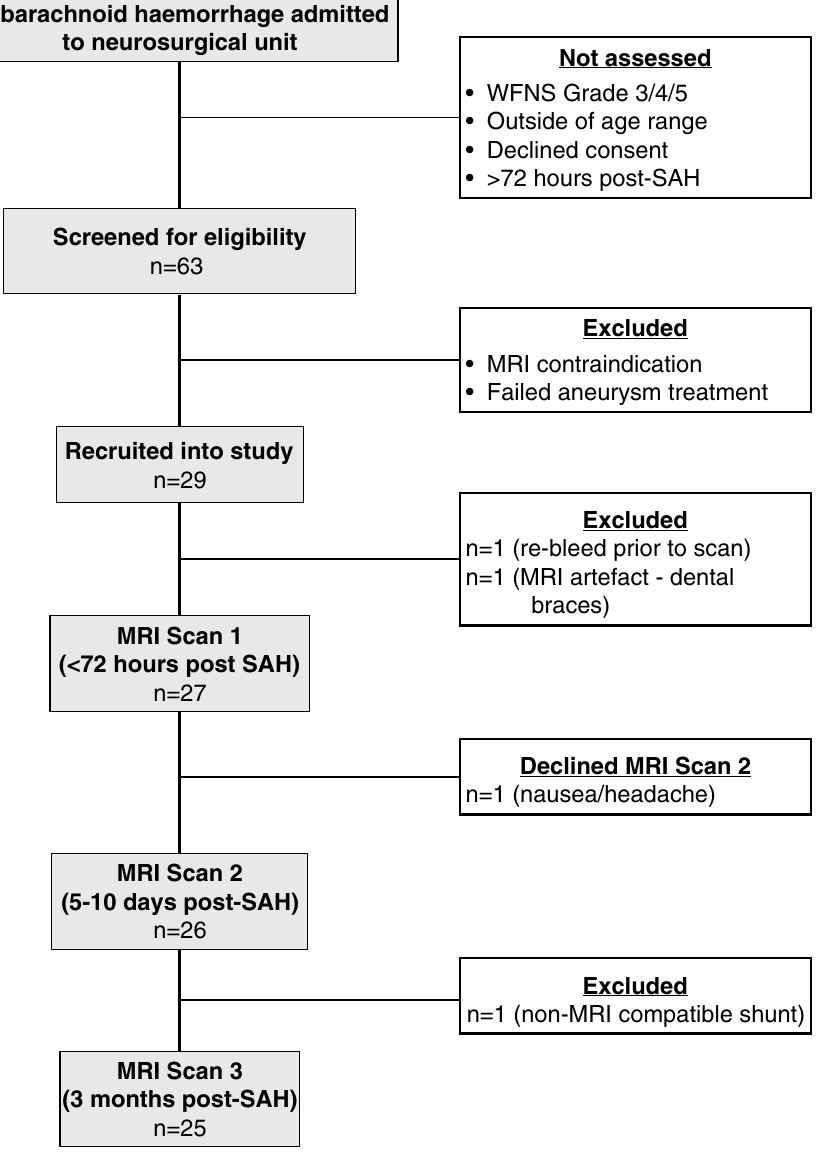
Figure 1. CONSORT diagram of study